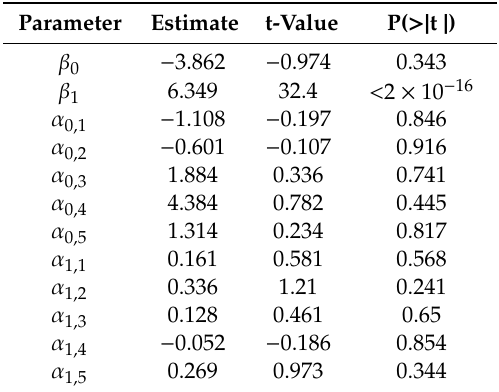
Table 1. The ANOVA results obtained using Equation (1). The null hypothesis of no di ff erences between intercepts and slopes was accepted for all situations.